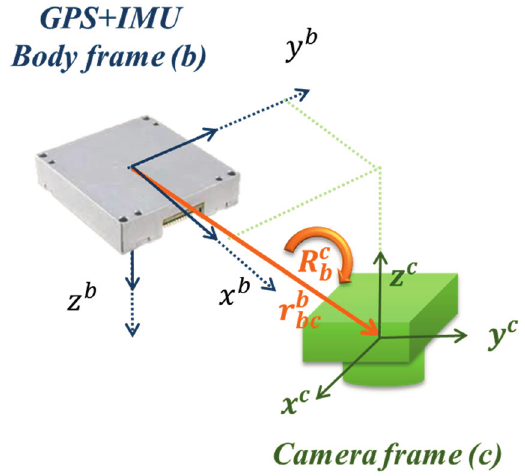
Figure 5. Concept of lever arm